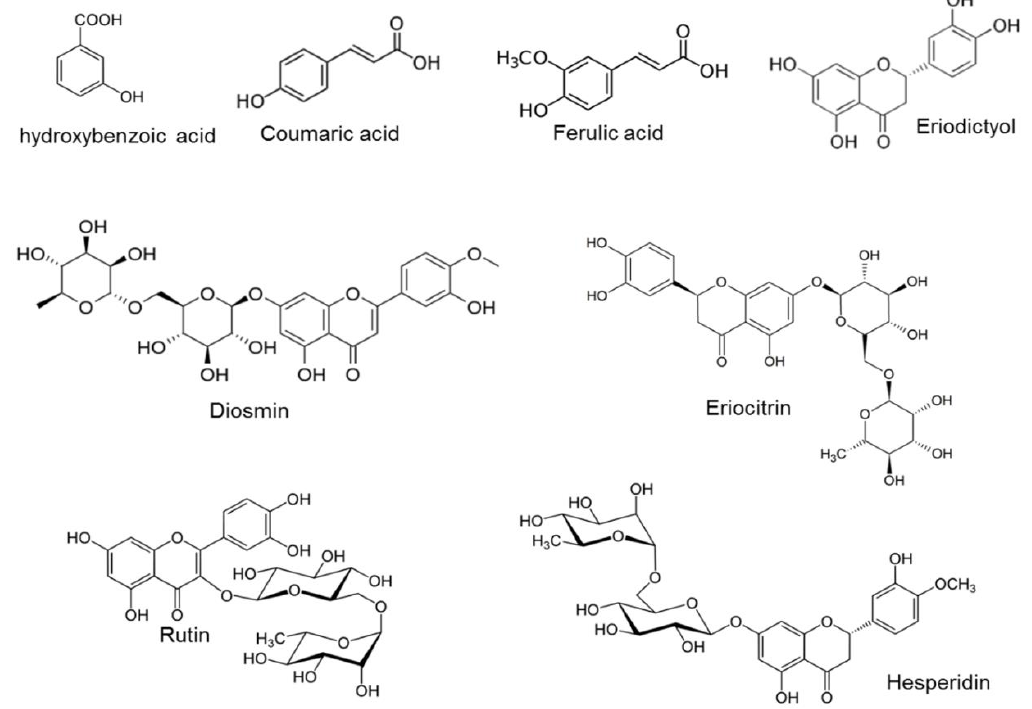
Figure 4. Major phenolic acids and flavonoids found in the crude LP extract.